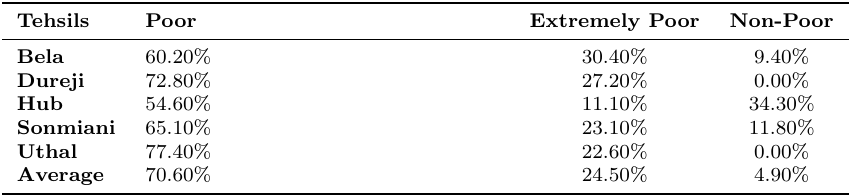
Table 4: Tehsil Wise Poverty Profile